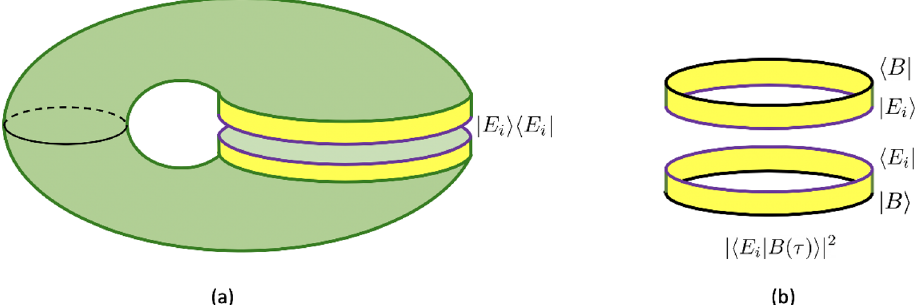
Figure 16 . Projecting on to a typical energy eigenstate in the (yellow) non-gravitational region. (a) We find the same type of bra-ket wormhole solution. (b) The dual interpretation, we have